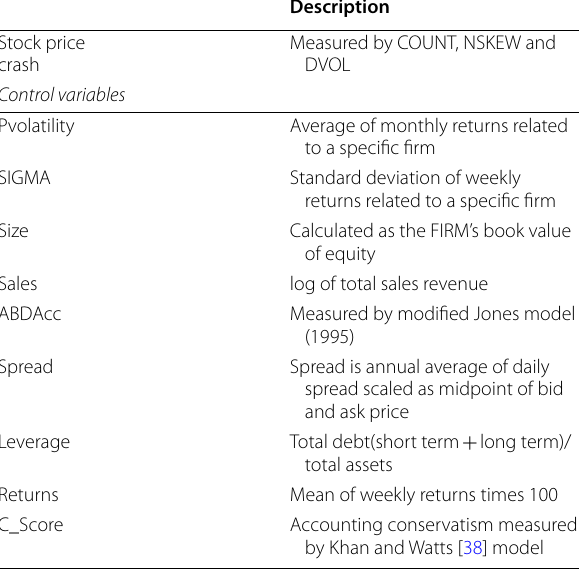
Table 5 REM and SPC